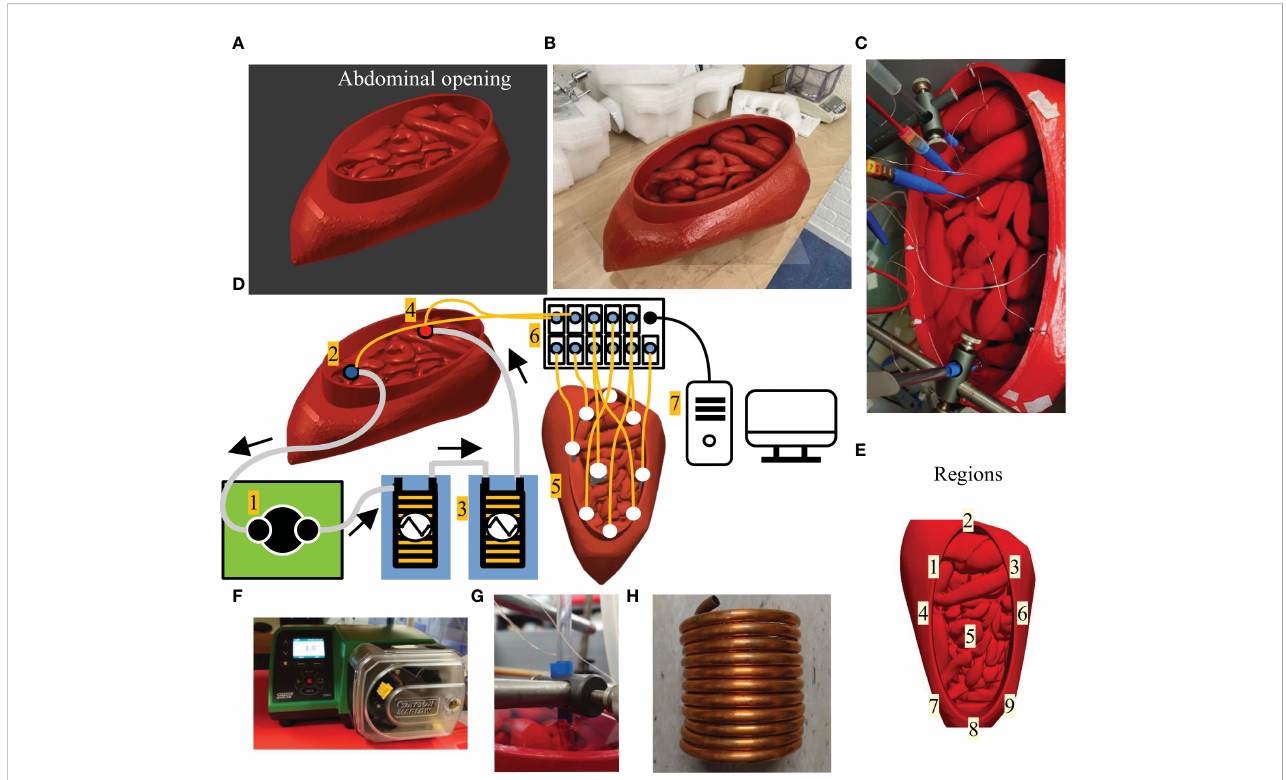
FIGURE 1 The 3D design of the phantom (A) and the 3D-printed phantom based on the design in A (B) . The oval opening of the peritoneal cavity (see label abdominal opening) mimics a “ Colosseum ” setup, often used during an open HIPEC treatment. Panel (C) shows a photograph of the phantom during experimentation. Schematic diagram of the setup used during experiments (D) . A roller pump (1) circulates water from the out fl ow (2) through two heat exchangers (3) placed inside water baths and back into the phantom (4). Temperatures are measured in 9 different regions (5) using 9 7-point thermocouple probes. The thermometry system (6) records temperatures which are monitored and stored on a PC (7). In panel (E) we visualize the location of the various probe regions used for evaluation of thermal pro fi les. Panels (F – H) show photographs of the roller pump, catheter tips locked in position and heat exchanger,